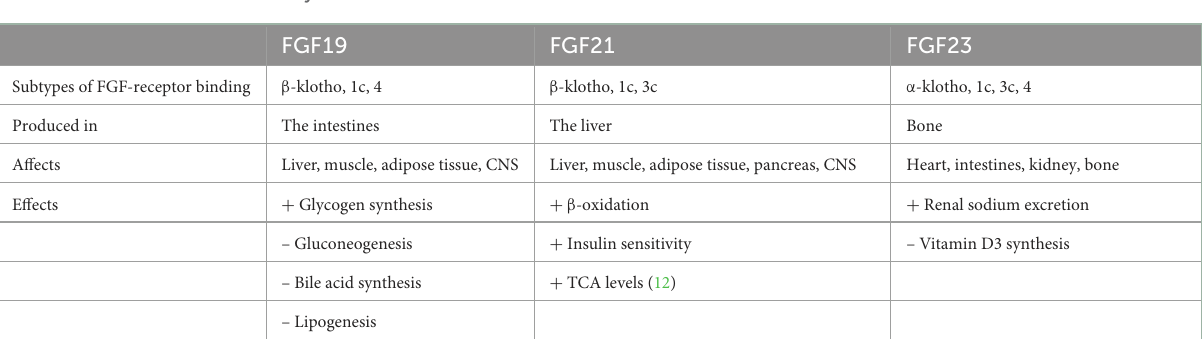
TABLE 1 Overview of the FGF19 family